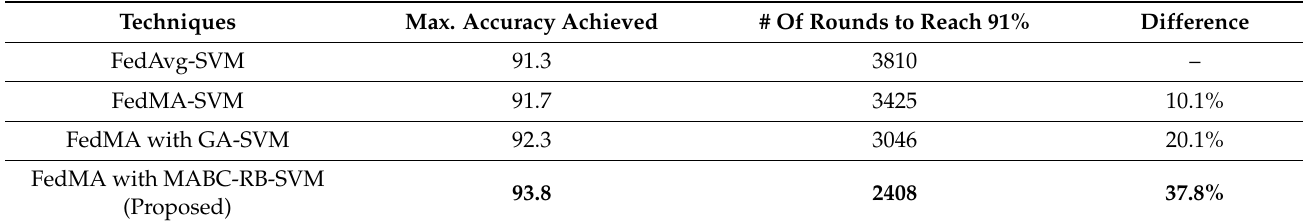
Table 3. Consumed algorithm time for the highest accuracy of the model.